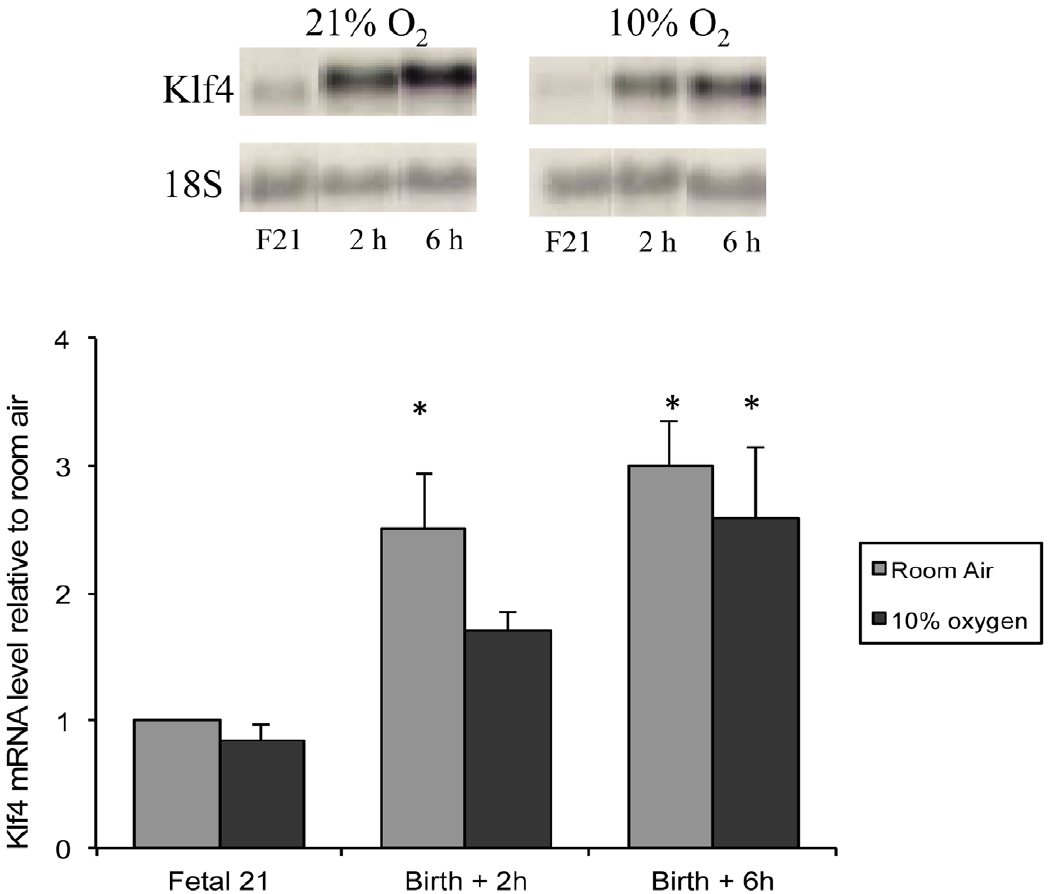
Figure 4. Klf4 Immunohistochemistry. Klf4 protein is detected within nuclei of interstitial cells and airway epithelial cells of perinatal lung in the left panel. Signal is absent with omission of primary antibody as a negative control in the middle panel. Signal is present in epithelial cell nuclei of adult colon as a positive control in the right panel.